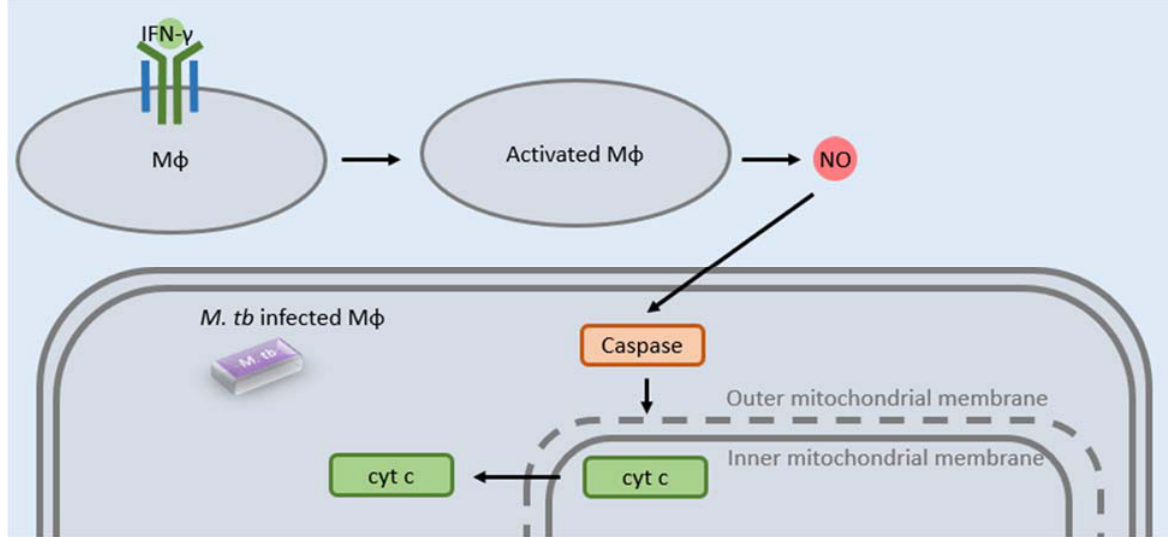
Figure 3. Nitric oxide (NO) produced by type II IFN ‐ activated macrophages induce apoptosis of mycobacteria ‐ infected macrophages by increasing outer mitochondrial membrane